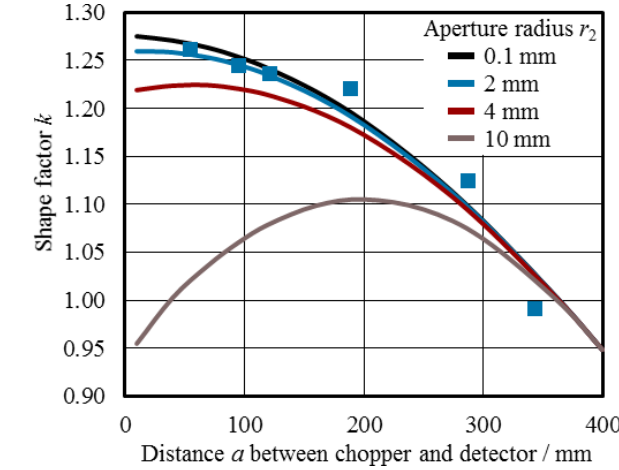
Figure 7. Theoretical calculation of the shape factors k for the cal- culation of the amplitude of the fundamental oscillation component of the modulated radiant flux on the detector at the blackbody fa- cility depending on the distance a between the chopper and the de- tector aperture for four different radii r 2 of the detector aperture. During the calibration process, a nominal distance of a = 70mm and a detector aperture radius of r 2 = 2mm was used, whereas the distance from the detector aperture to the blackbody aperture was d = 400mm. The radius of the blackbody aperture was r 1 = 10mm for all cases. The blue dots represent the relative signal of the lock- in measurement of the pyroelectric detector depending on the dis- tance a to verify the given